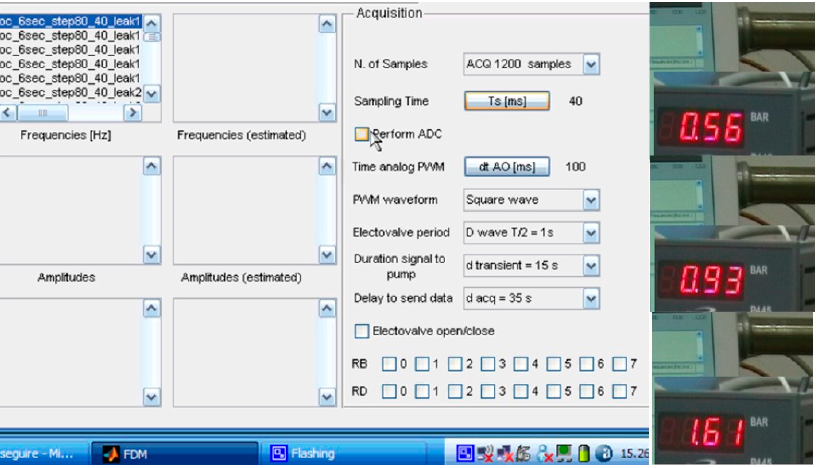
Figure 16. MATLAB-based program shell for performing the acquisitions according to different parameters and advanced transforms.